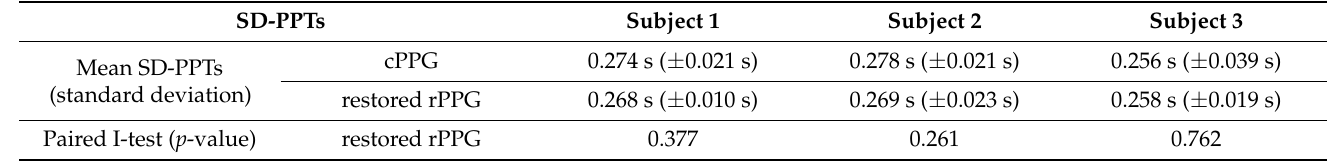
Figure 8. Example of second differentiation result for peak detection of cPPG, rPPG, and restored rPPG: ( a ) The result of second differentiation of cPPG, rPPG, and restored rPPG (using SVR + deep); ( b ) the result of applying and inverting the Savitzky–Golay filter in ( a ). Table 4. The mean SD-PPTs and paired t -test results of SD-PPTs of three 23-year-old subjects.